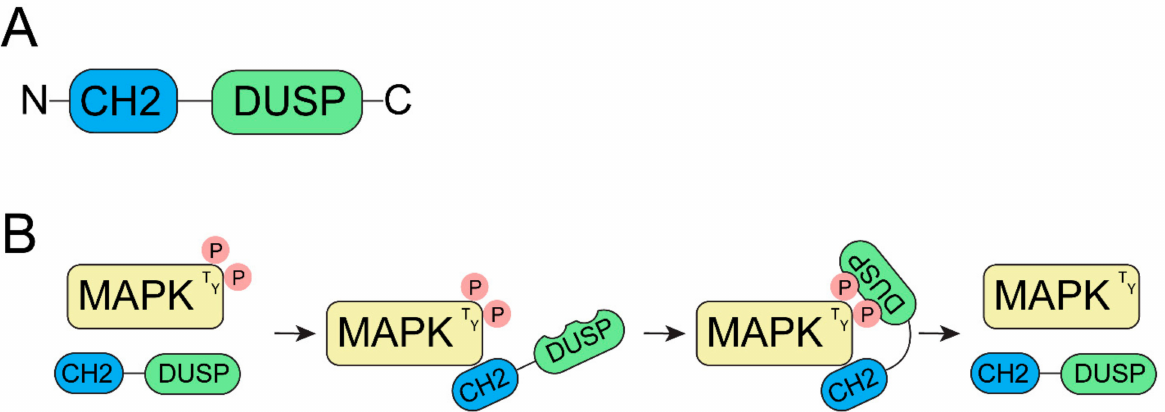
Figure 2. MKPs regulate MAPKs. ( A ) The domains of a canonical MKP. MKPs have two domains, a C-terminal catalytic DUSP domain that dephosphorylates MAPKs and an N -terminal CH2 domain that binds the MAPK-binding domain. The CH2 domain recognizes and docks the specific MAPK substrate, stabilizing it for dephosphorylation. ( B ) The DUSP domain of MKPs dephosphorylates T and Y residues in the MAPK activation loop (pTXpY), downregulating MAPK activation. The CH2 domain of the MKP binds the MAPK, inducing a conformational change, which activates and increases the catalytic activity of the MKP DUSP domain. This promotes the DUSP active site to dephosphorylate the MAPK residues, thereby inactivating the